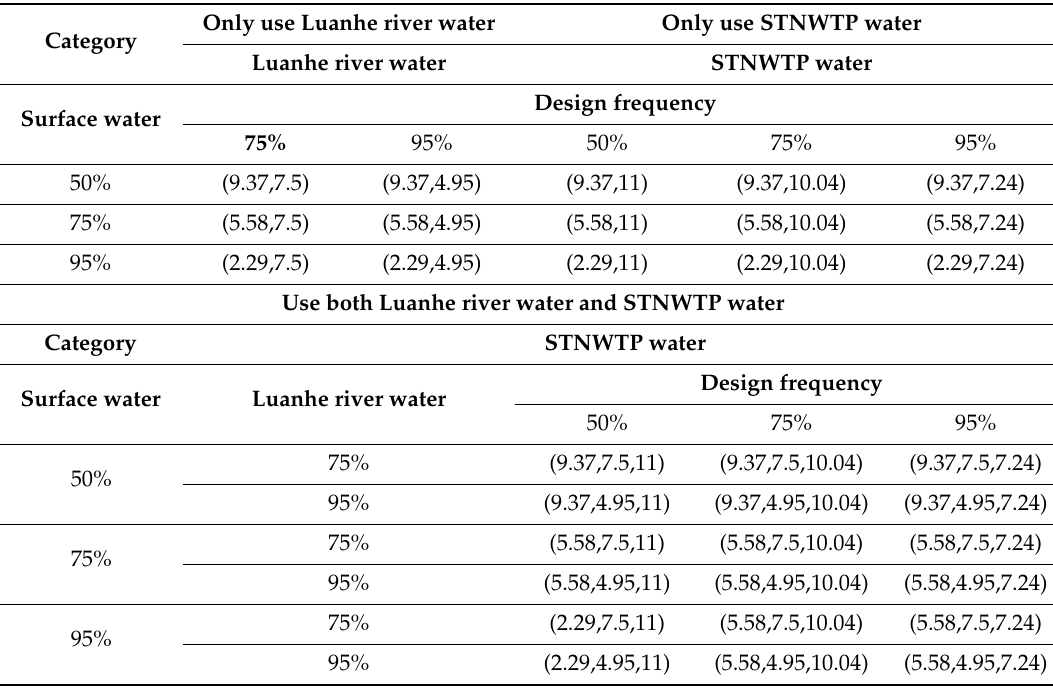
Table 5. Simulation scheme settings (units = 10 8 m 3